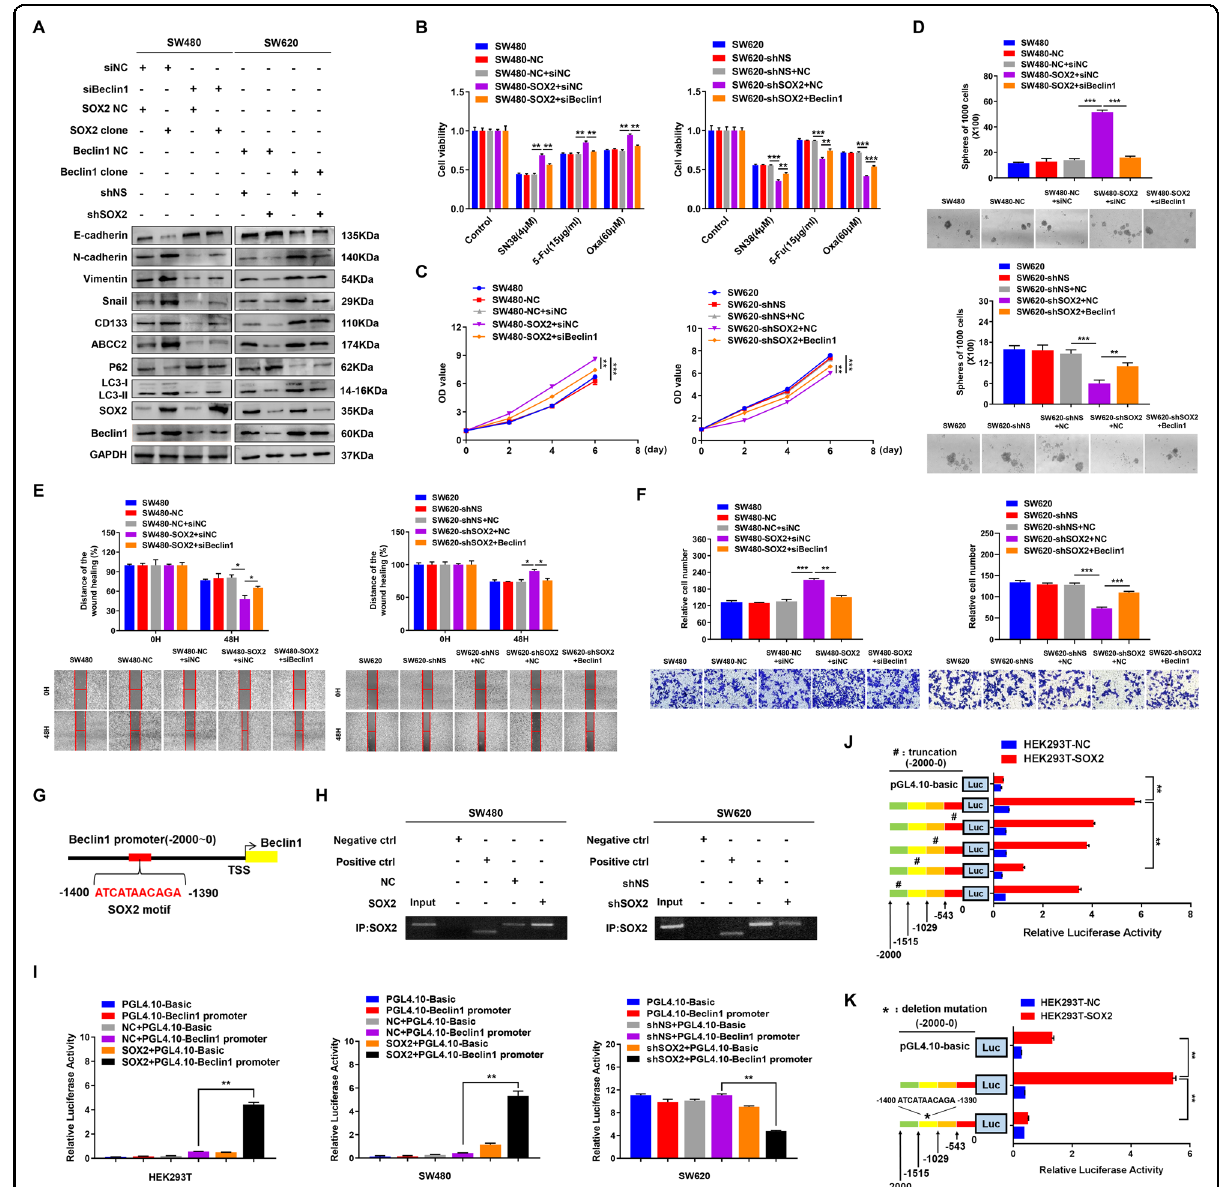
Fig. 4 Beclin1 is responsible for SOX2-induced autophagy activation, chemoresistance, CSCs properties, and EMT in CRC. A Overexpression or knockdown of Beclin1 was conducted in SW480 or SW620 cells transfected with SOX2 clone or SOX2 shRNA, then western blot was performed with indicated antibodies. B – F The ability of chemoresistance ( B ), proliferation ( C ), stemness ( D ) migration ( E ), and invasion ( F ) was examined in SW480 cells co-transfected with SOX2 clone and Beclin1 siRNA or in SW620 cells co-transfected with SOX2 shRNA and Beclin1 clone by drug sensitivity assay, cell viability assay, tumor sphere formation assay, wound healing assay, and transwell invasion assay, respectively. G Schematic map of potential SOX2-binding site in the promoter of Beclin1 was shown according to the JASPAR database. H ChIP assay analysis of the interaction between SOX2 and Beclin1 promoter in SW480 and SW620 cells transfected with SOX2 clone or SOX2 shRNA. IgG antibody was used as a negative control, RNA polymerase II antibody was used as a positive control. I Beclin1 promoter-driven luciferase activity was assessed in HEK293T, SW480, and SW620 cells transfected with SOX2 clone or SOX2 shRNA. J , K Luciferase activity of Beclin1 promoter was examined in HEK293T cells transfected with truncated Beclin1 promoter ( J ) or deletion mutant of Beclin1 promoter ( K ). Experiments were conducted in triplicate. Data are shown as mean ± SEM. * P < 0.05, ** P < 0.01, and *** P <